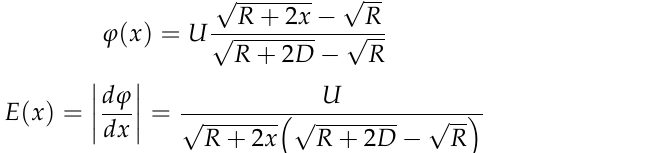
Figure 2. Real configuration of the coaxial air diode “tubular edge cathode–flat anode” from the experiments [30,31,36].